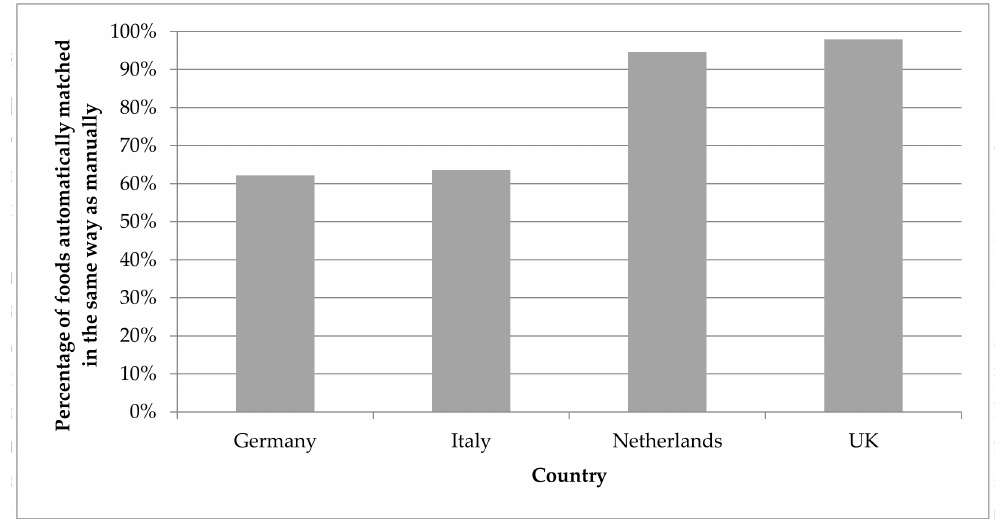
Figure 8. Percentage of foods from the food consumption survey that were assigned the same match from the food composition database in the testing exercises and in the previous manual match.